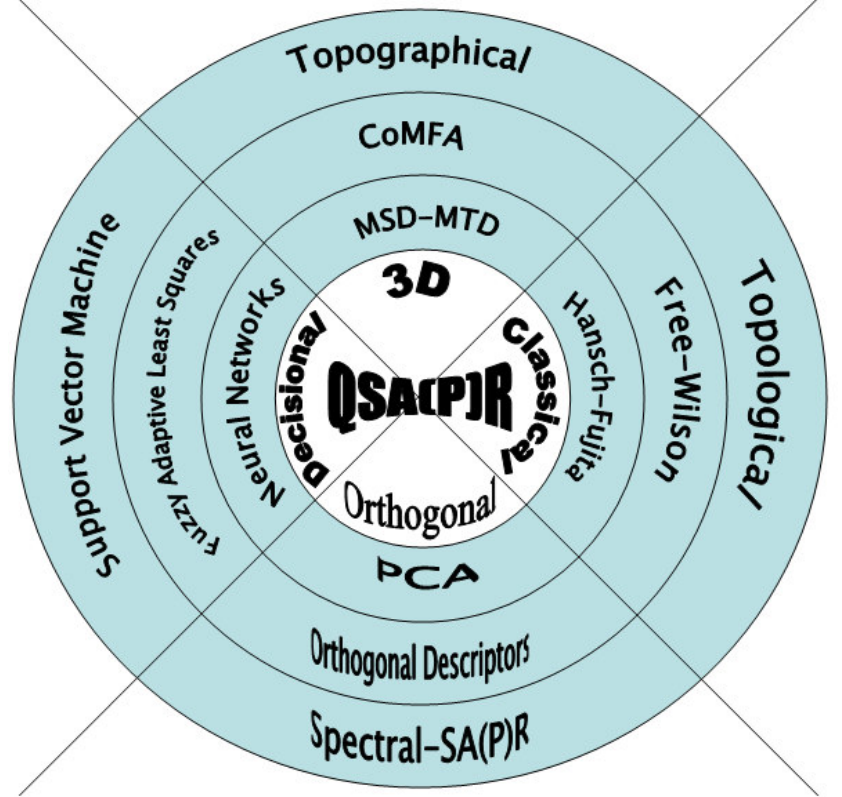
Figure 1. Generic world of the quantitative structure-activity/property relationships - QSA(P)R - through classical, 3D, decisional and orthogonal methods of multivariate analysis of the chemical- biological interactions. In scheme MSD-MTD, CoMFA, and PCA stand for the “minimal steric difference-minimal topological difference”, “comparative molecular field analysis” and “principal component analysis”,